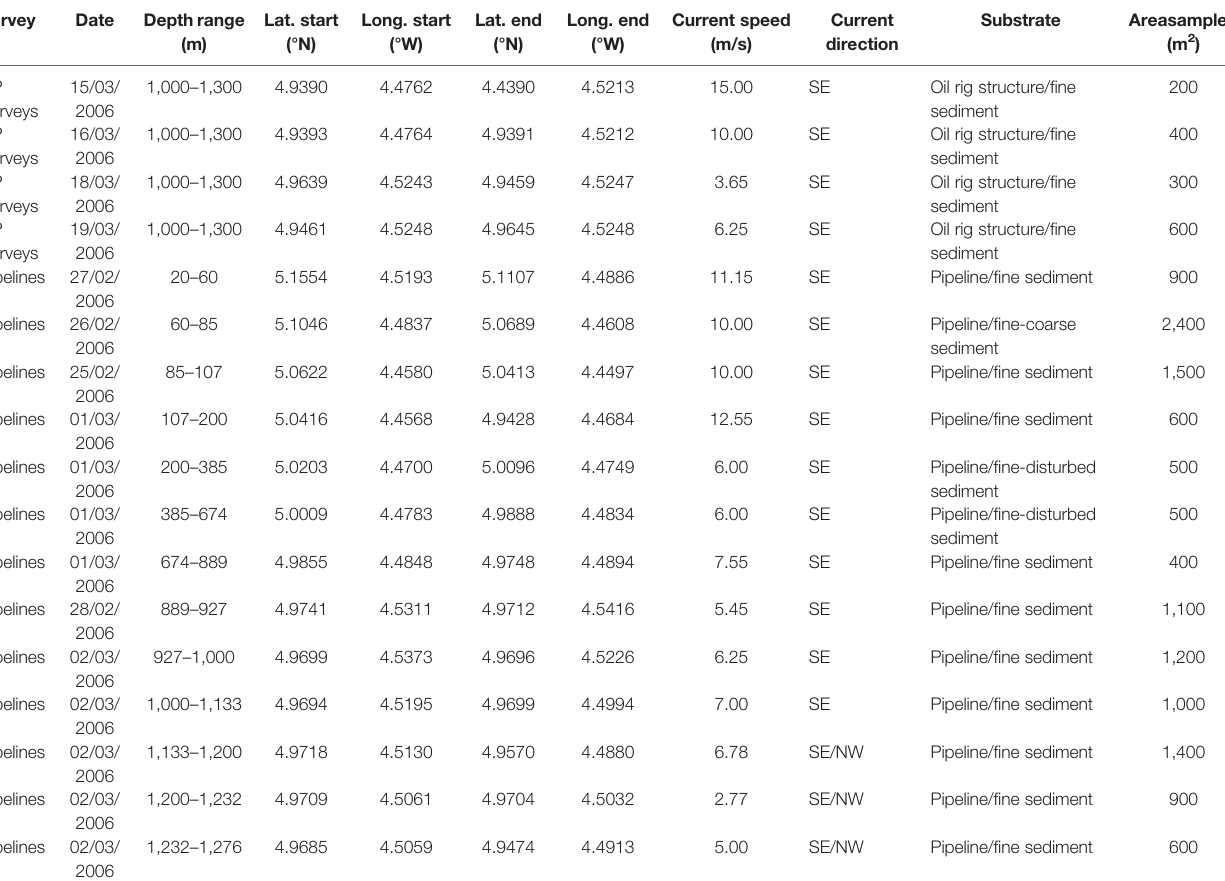
TABLE 1 | Ivory Coast remotely operated vehicle (ROV) video survey